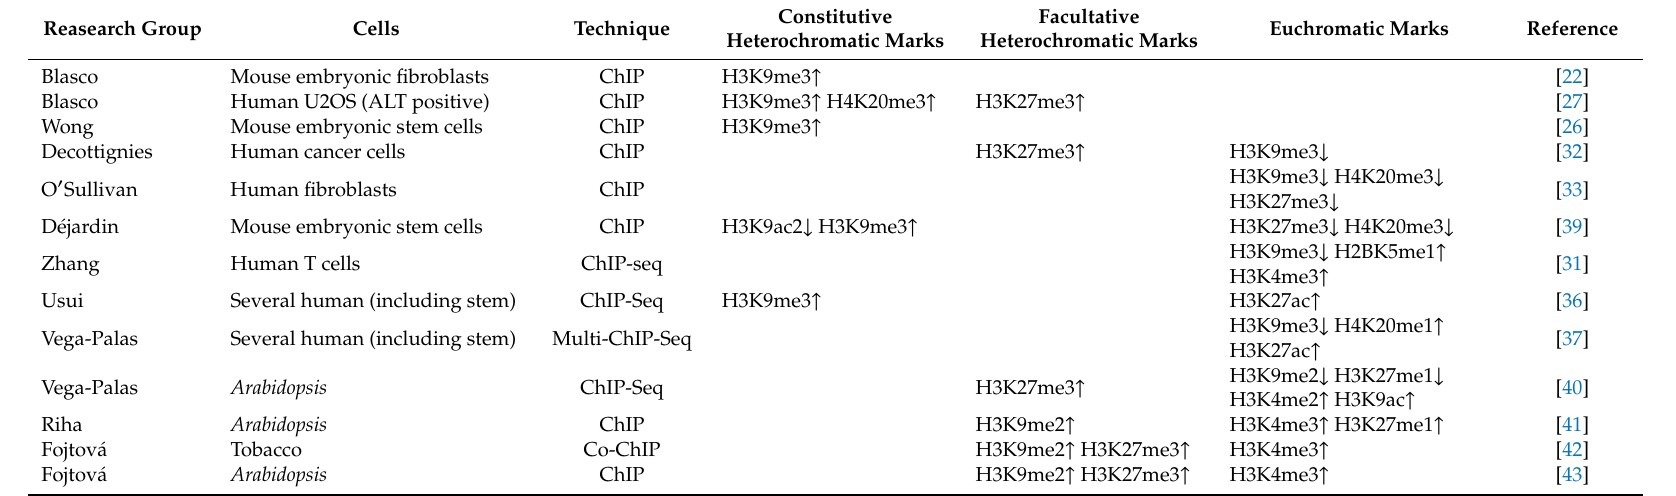
Table 1. Studies on telomeric epigenetic features. ChIP: Chromatin